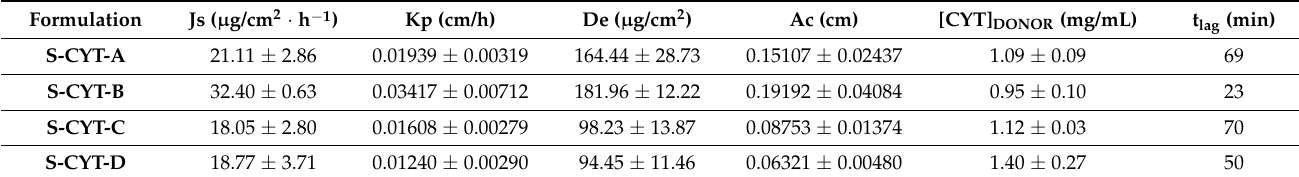
Table 5. CYT biopharmaceutical parameters calculated by the ex vivo evaluations: Js ( µ g/cm 2 · h − 1 ), Kp (cm/h), De ( µ g/cm 2 ), Ac (cm) and t lag (min) together with CYT experimental concentration into the donor chamber ± SE (n =